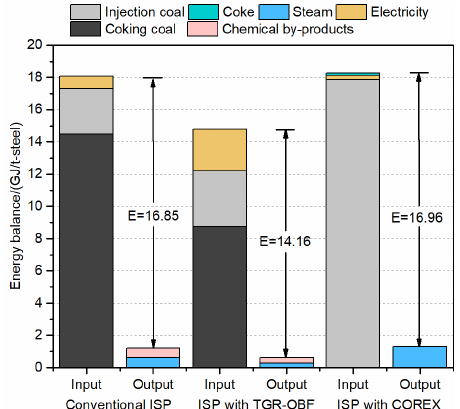
Figure 9. The energy balance in the conventional ISP, the ISP with the TGR-OBF, and the ISP with the COREX. the